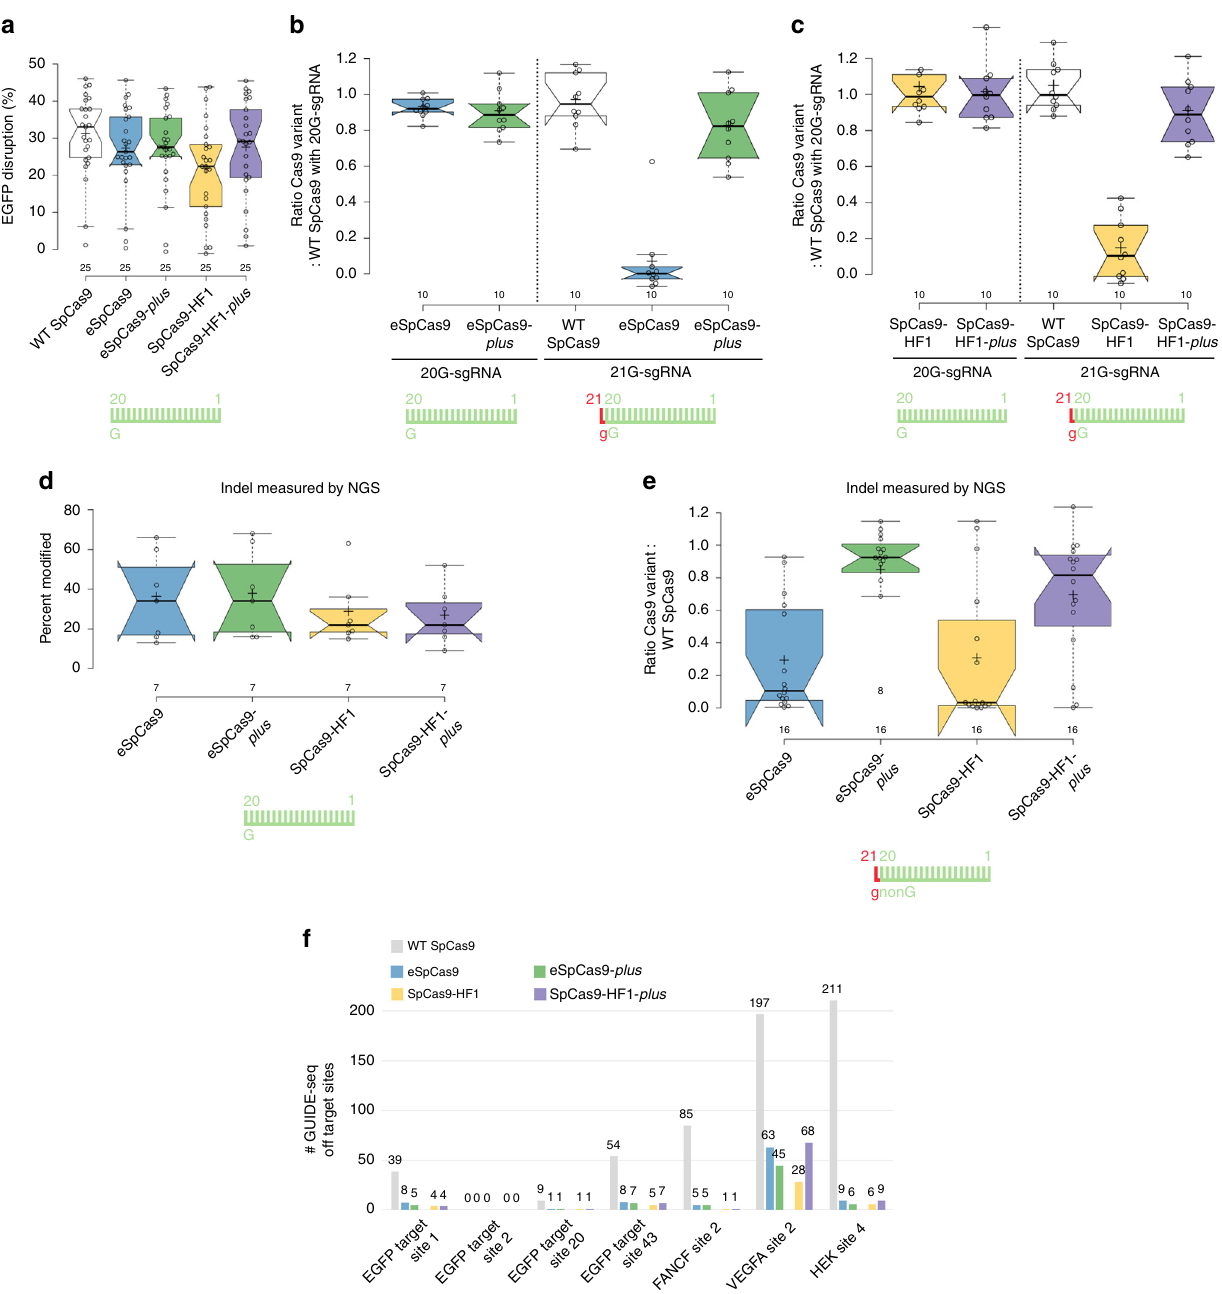
Fig. 5 eSpCas9- plus and SpCas9-HF1- plus show greatly enhanced on-target activity with 21G-sgRNAs and identical fi delity/target-selectivity compared to eSpCas9 and SpCas9-HF1, respectively, as assessed by EGFP disruption, indels measured by NGS and by GUIDE-seq. a – c EGFP-disruption activity a with 20G-sgRNAs targeting 25 sites; b , c with either 20G- or 21G-sgRNA pairs targeting two alternative sets of 10 different sequences shown as the ratio of variant activity to WT activity. d , e On-target activities of SpCas9 variants across 23 endogenous target sites within the human VEGFA or FANCF loci targeted with d 20G- or e 21G-sgRNAs, measured by amplicon resequencing. f Bar chart of the total number of off-target sites detected by GUIDE-seq for SpCas9 variants on seven sites targeted with 20G-sgRNAs. a – e Tukey-type boxplots by BoxPlotR 60 : center lines show the medians; box limits indicate the 25th and 75th percentiles; whiskers extend to the “ minimum ” and “ maximum ” data situated within 1.5 times the interquartile range from the 25th and 75th percentiles, respectively; notches indicate the 95% con fi dence intervals for the medians; crosses represent sample means; data points are plotted as open circles representing the mean of biologically independent triplicates. Spacers are schematically depicted beside the charts as combs: green color teeth indicate matching-, while a red color tooth indicates the presence of an appended nucleotide within the spacer; numbering of tooth position corresponds to the distance of the nucleotide from the PAM; the starting 20th nucleotide of the spacer is indicated by an uppercase letter and an appended 21st nucleotide by a red lowercase letter. See also Supplementary Figs. 6 and